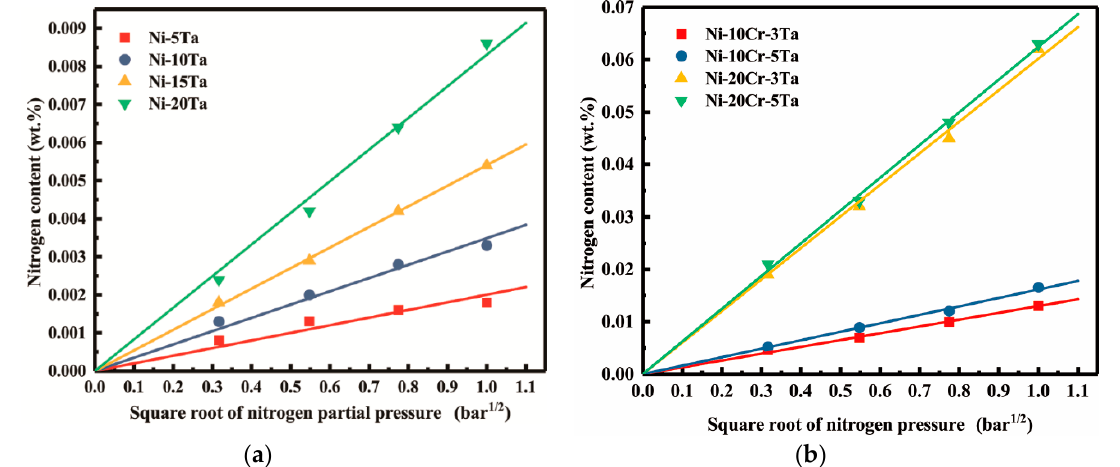
Figure 6. ( a ) Effect of pressure on the solubility of nitrogen in liquid Ni-Ta alloys at 1873 K ; ( b ) Effect Figure 6. ( a ) E ff ect of pressure on the solubility of nitrogen in liquid Ni-Ta alloys at 1873 K; ( b ) E ff ect of of pressure on the solubility of nitrogen in liquid Ni-Cr-Ta alloys at 1873 K. pressure on the solubility of nitrogen in liquid Ni-Cr-Ta alloys at 1873 K.